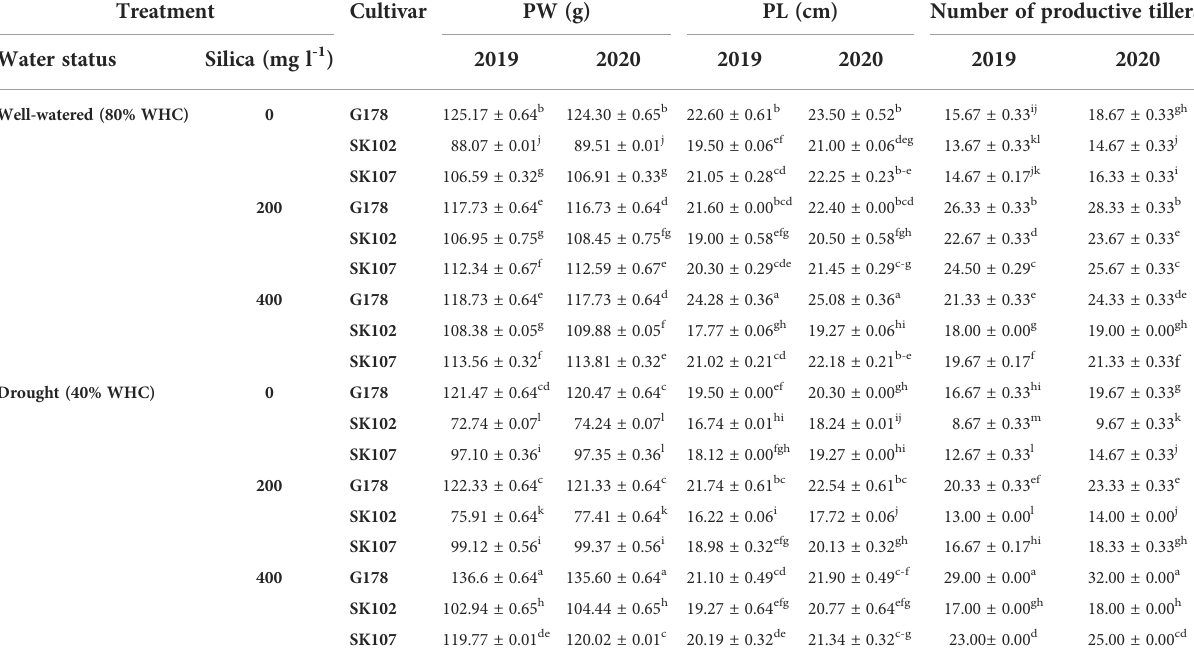
TABLE 2 Effects of foliar application of silica on some yield components in response to drought stress during the growing seasons of 2019 and 2020.